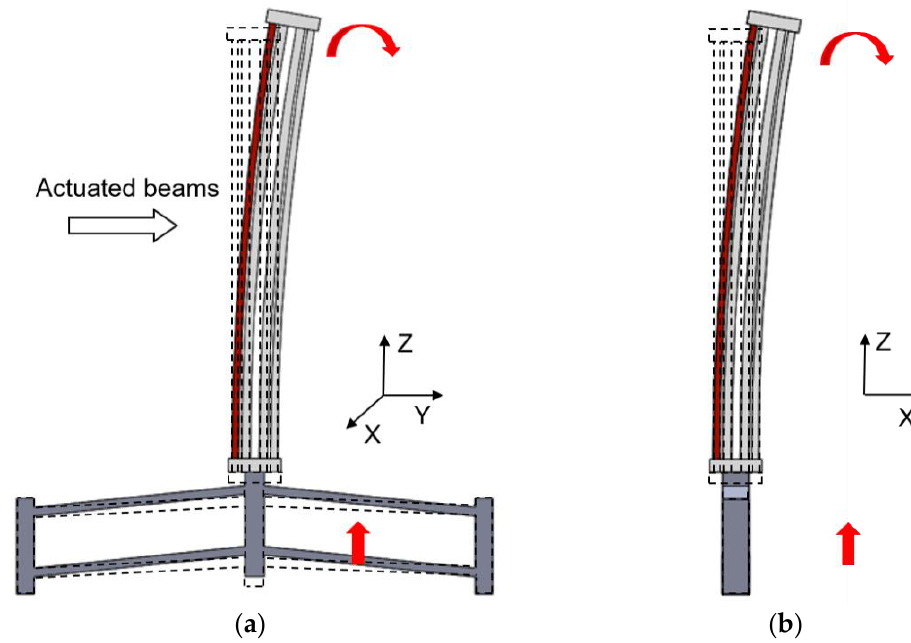
Figure 3. Deformation of the 3D U-shaped and V-shaped actuator. ( a ) The 3D U-shaped actuator bends to axis-Y and V-shaped actuator bends to axis-Z; ( b ) The 3D U-shaped actuator bends to axis-X and V-shaped actuator bends to axis-Z.